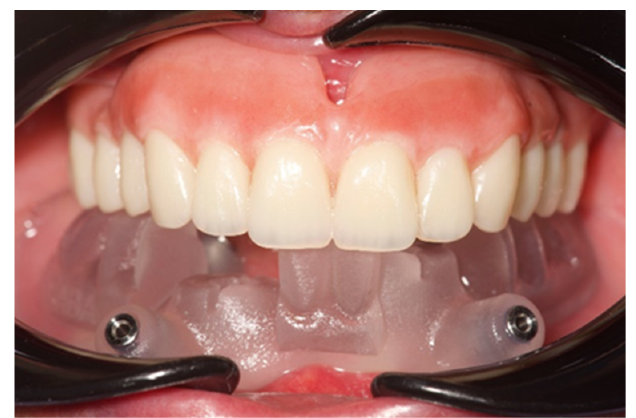
Figure 5. Surgical template without metallic sleeves.